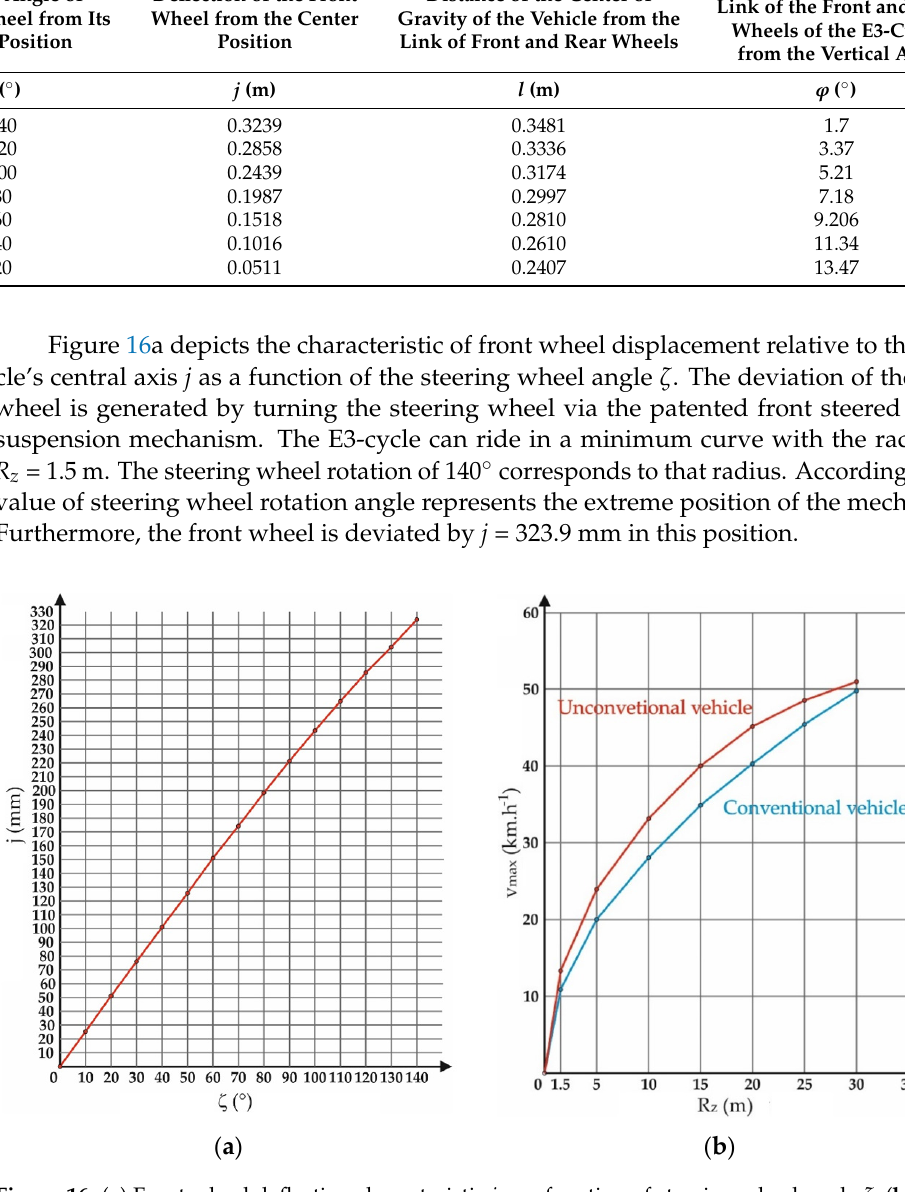
Table 2. Comparison of the theoretically obtained maximum vehicle speeds in the course of cor- nering.